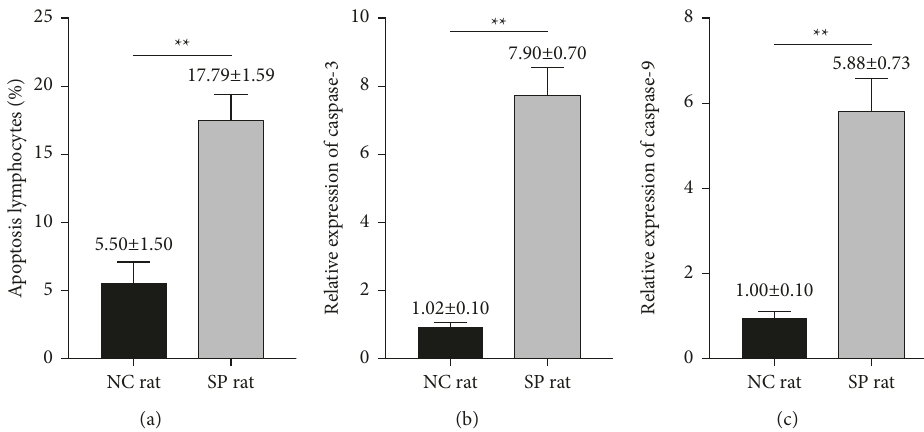
Figure 2: Indicators related to apoptosis were changed in lymphocytes of septic rats. (a) The percentages of apoptotic lymphocytes in eight- paired NC rat group and SP rat group were determined by flow cytometry [ t value � 16.387, p < 0.01]. ((b) and (c)) The relative expressions of caspase-3 and caspase-9 mRNA in eight-paired NC rat group and SP rat group were determined by real-time quantitative PCR [ t value (caspase-3) � 26.246, p < 0.01; t value (caspase-9) � 18.489, p < 0.01]. NC group: normal control group; SP group: sepsis group. ∗∗ p < 0.01.